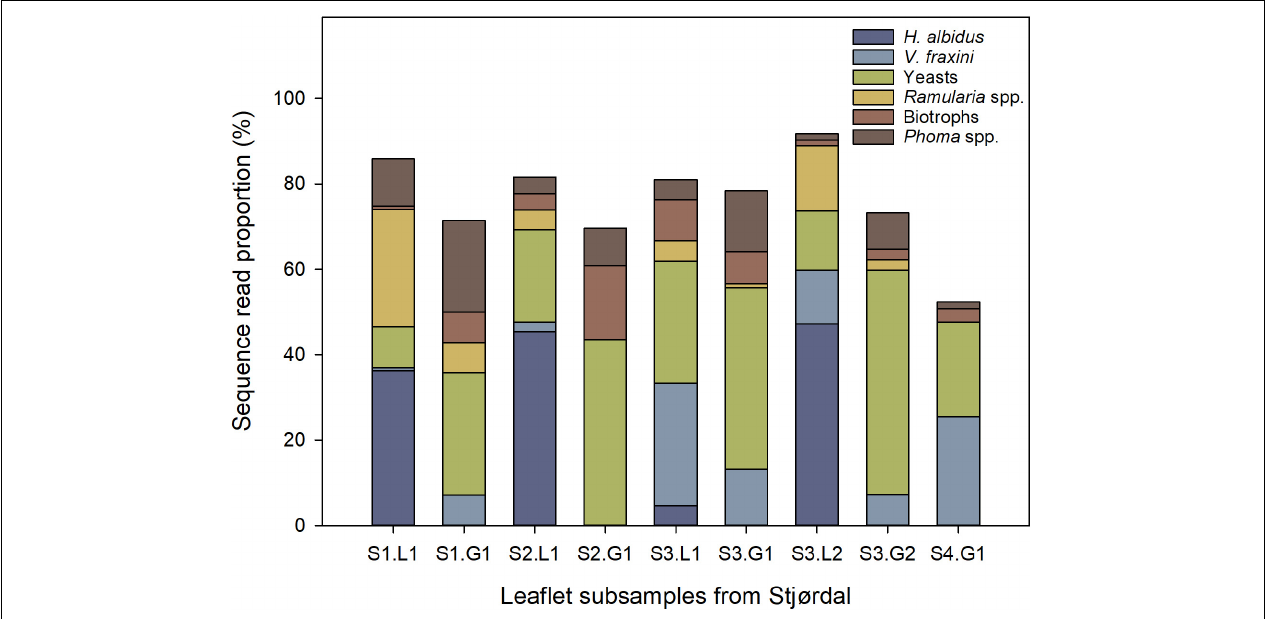
FIGURE 3 | Relative abundance of H. albidus and other prominent species or functional groups in four ash leaflets from four different ash saplings from the Stjørdal site (S), L referring to lesion area, and G to asymptomatic green tissue. The sample S4.L1 was excluded owing to the low sequence read count. The number following S refers to the leaflet number, and the number following L or G refers to subsample number.